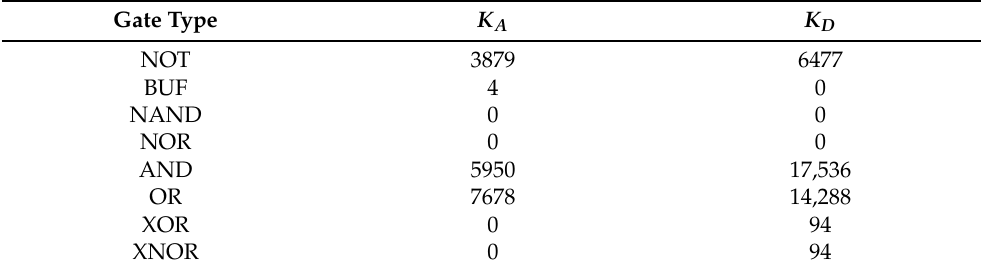
Table 6. Evaluation of SKG-Lock+ against removal attacks after re-synthesis ( n = 64).